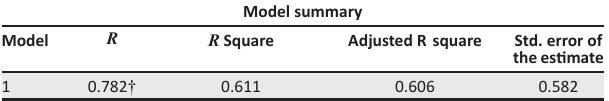
TABLE 6a: Moderation analysis.